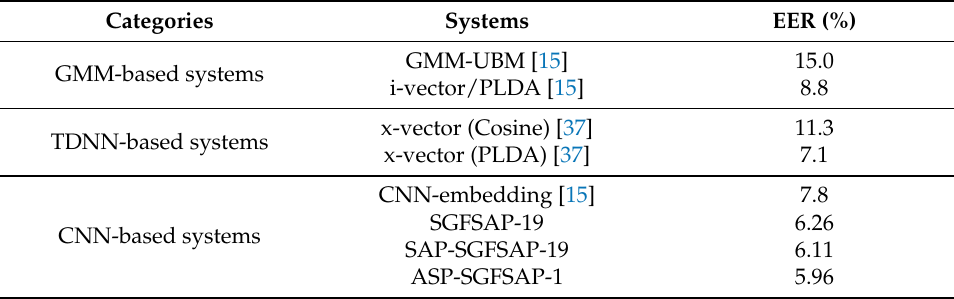
Table 3. The experimental results of various SV systems on Voxceleb.